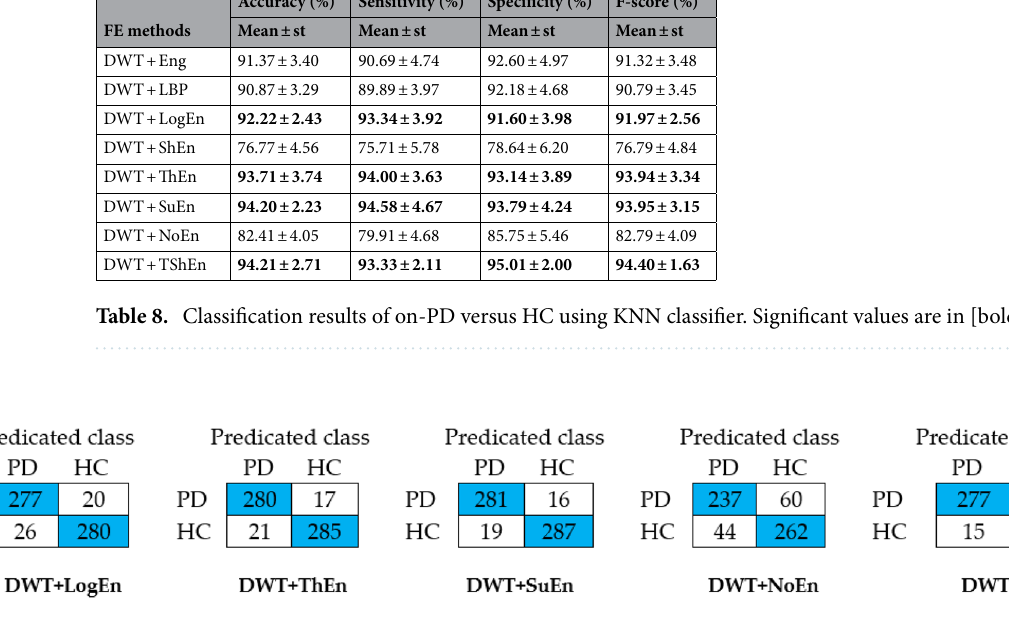
Figure 9. Confusion matrices for KNN classifier and different FE methods (on-PD vs. HC).